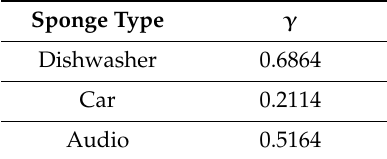
Table 6. The obtained values of γ for each of the sponge types and concentrations of SDS solution using distilled water.